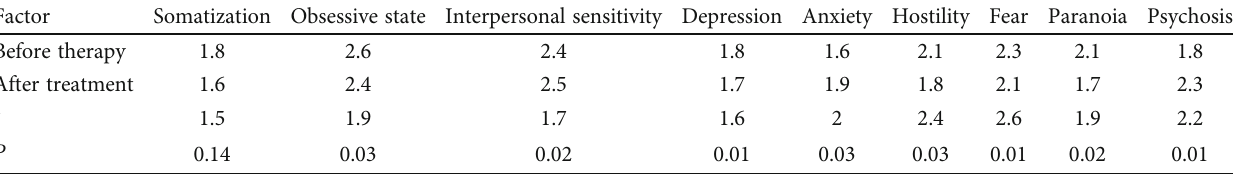
Table 2: Comparison of SCL-90 stability evaluation results before and after psychological counseling.